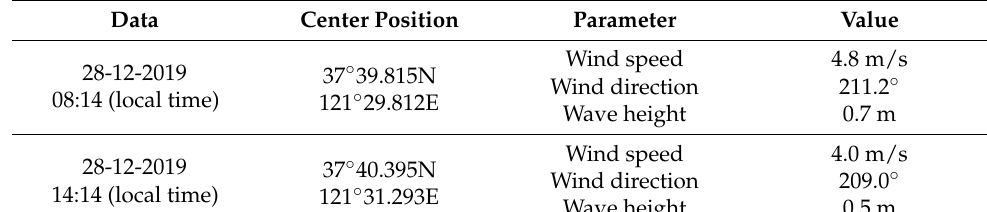
Table 6. Summary of the sea states during data acquisition.